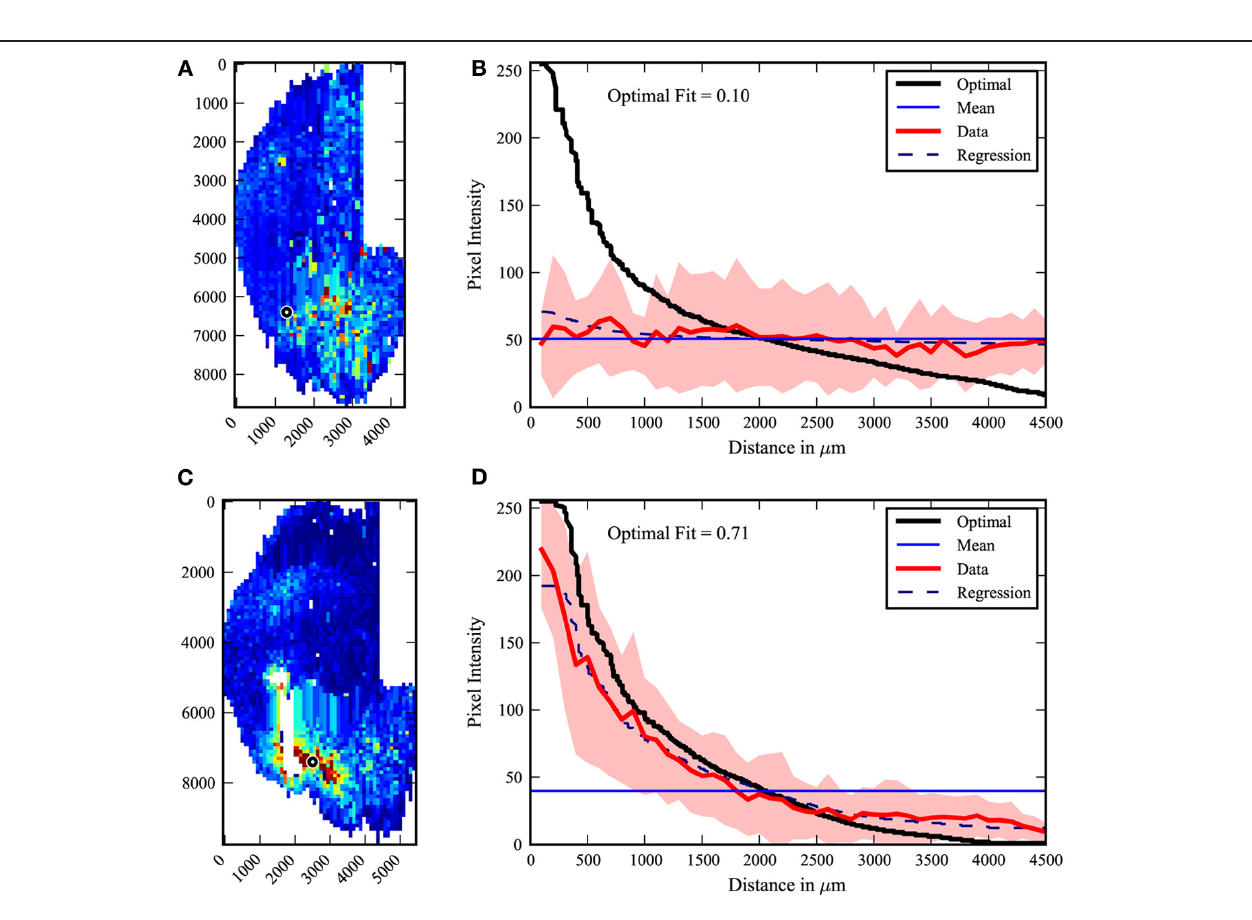
FIGURE 4 | Center-surround extremes. The least (top A , B ) and best (bottom C , D ) fit of the 22 data maps to a center-surround model. Left (A , C) : raw maps, right (B , D): graphic data. While the least fit is an outlier, it was